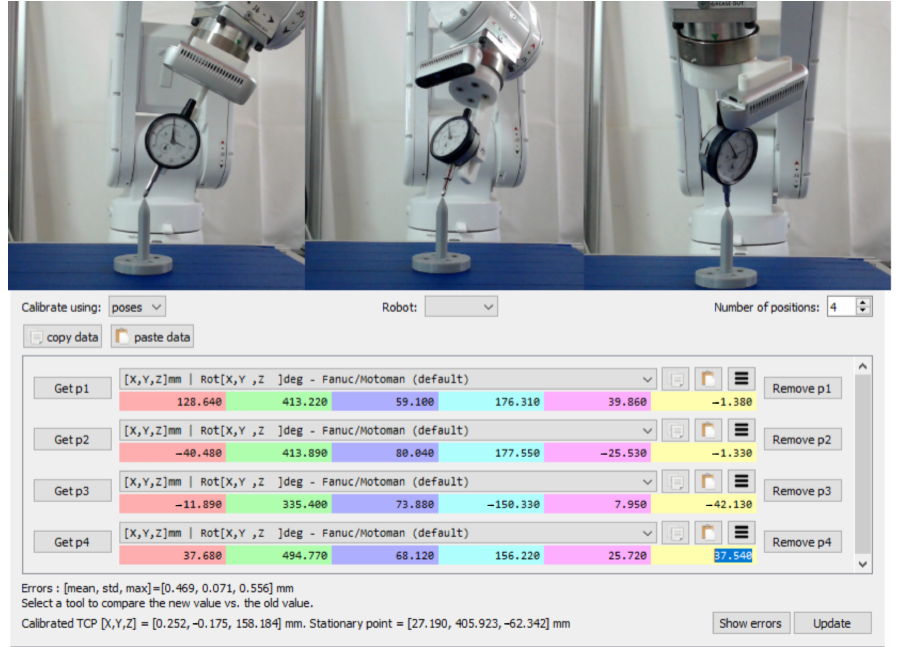
Figure 6. Calibration method of the depth measurement